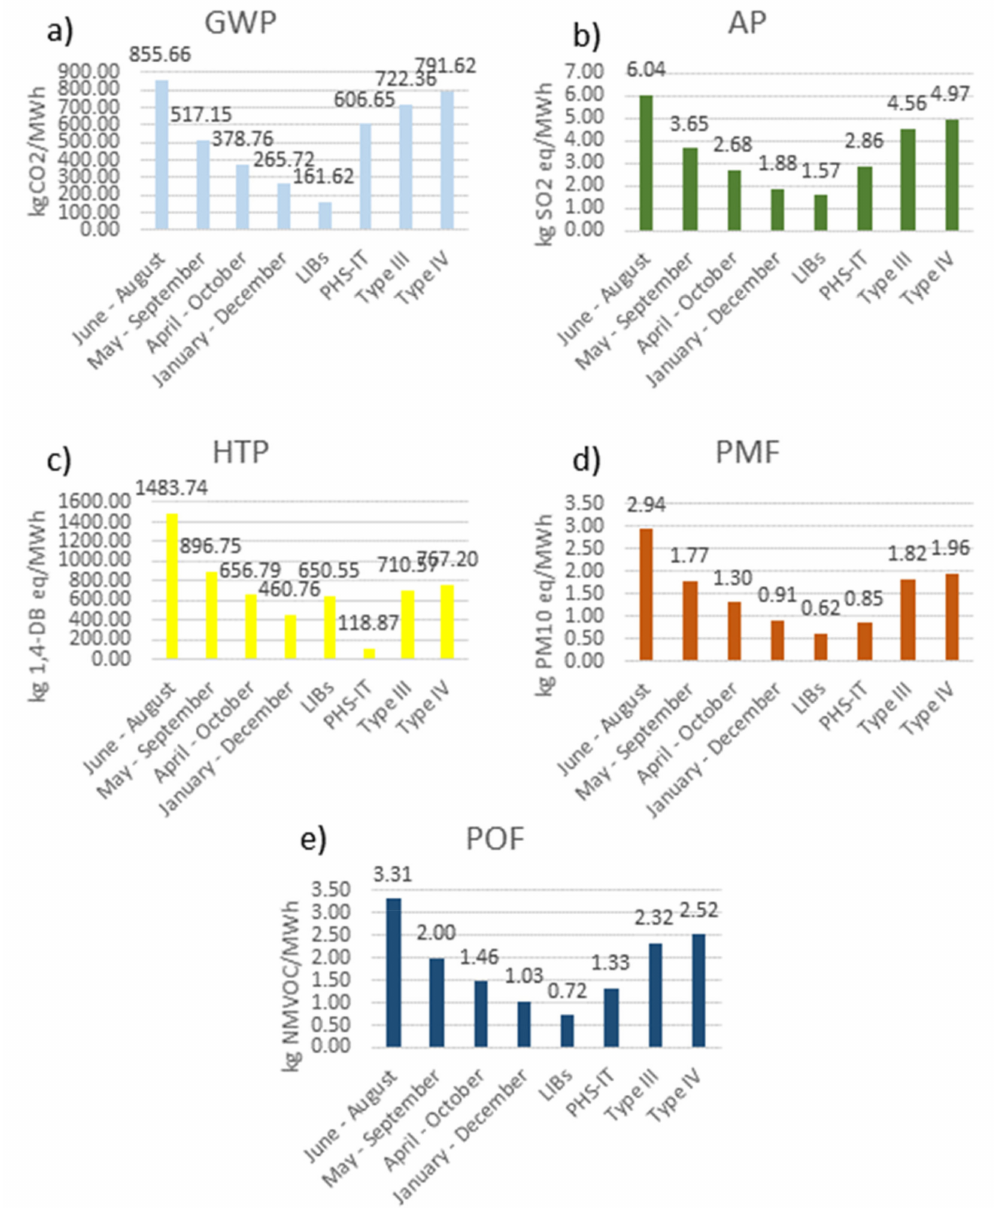
Figure 3. Midpoint environmental impacts of the analyzed systems for the impact categories: ( a ) GWP; ( b ) AP; ( c ) HTP; ( d ) PMF and ( e )